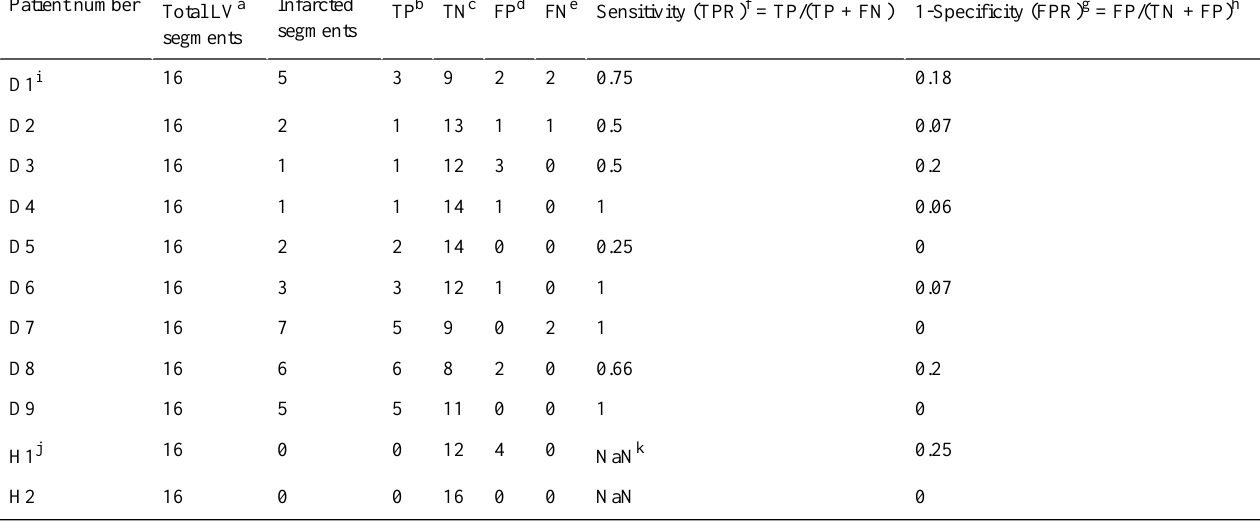
Table 4. Results of detecting infarcted left ventricular